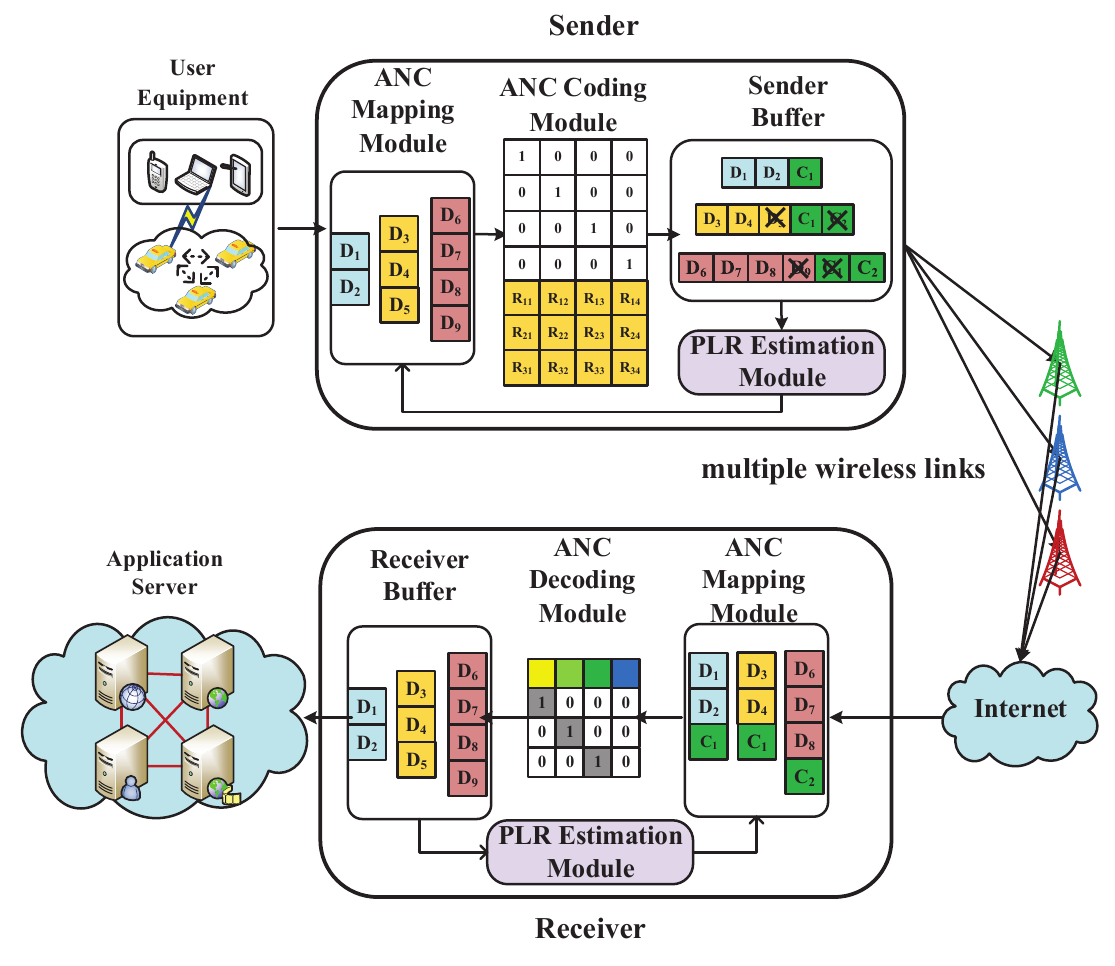
Figure 1. The architecture of the ANC